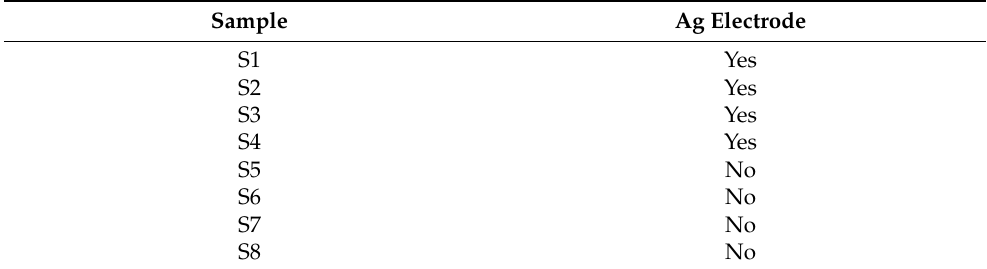
Table 1. Table describing the investigated samples. Sample Ag Electrode